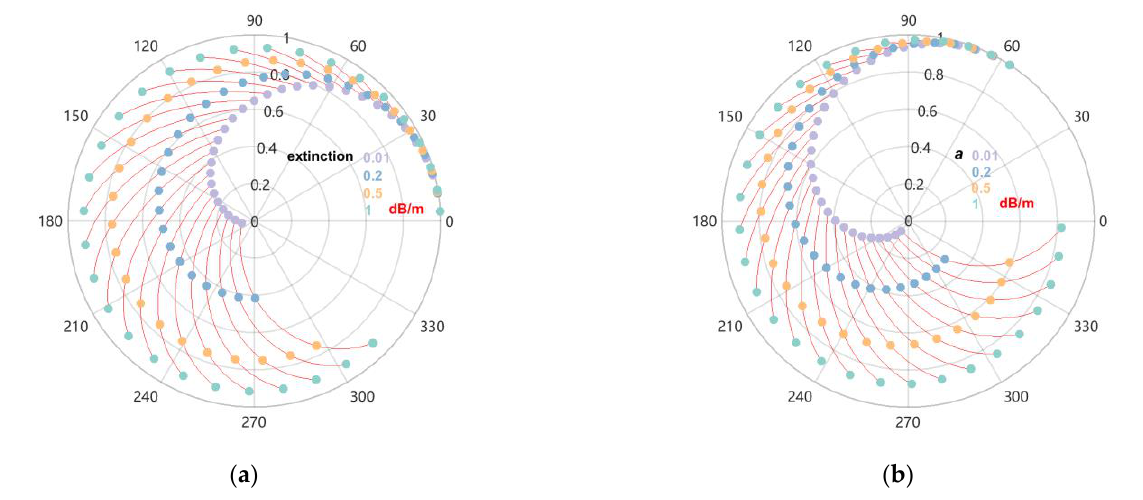
Figure 8. Comparative diagram of complex coherence before and after applying the improved extinction coefficient. The interference coherence on the complex plane is represented as a random volume in red, with h v of 0–30 m. In ( a , b ), the constant extinction coefficient values and the extinction coefficient influencing factor values of 0.01, 0.2, 0.5 and 1 dB/m are shown in purple, blue, yellow and green, respectively. In ( a ), the red segment is the RVoG model corresponding to the given constant extinction random volume height, and in ( b ), the red segment is the semi-empirical improved RVoG inversion model corresponding to the given extinction coefficient influence factor random volume height.